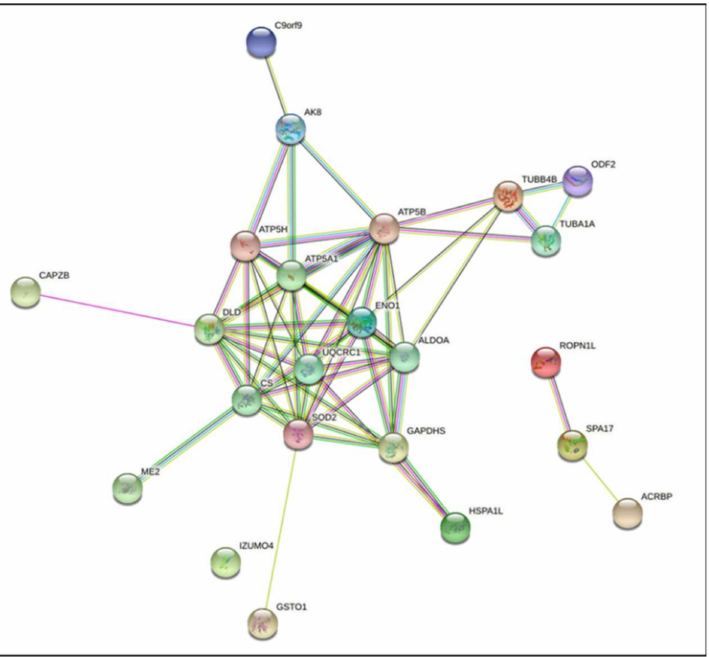
Figure 8. STRING protein association analysis of proteins showing changes in oxPTM levels after 6 h of incubation under capacitation-supporting conditions. Proteins are listed and characterised in Table 1. Network nodes represent proteins, and the connecting lines represent protein–protein